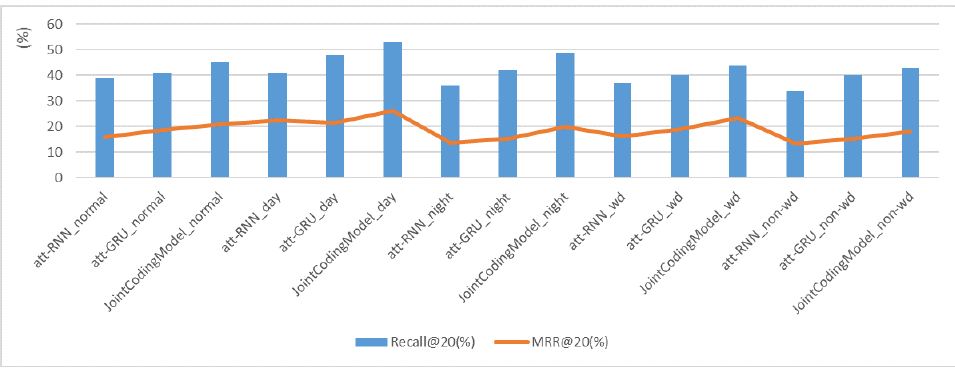
Figure 6. Trends of Recall@20 and MRR@20 of different dimensional data in experiment 1.